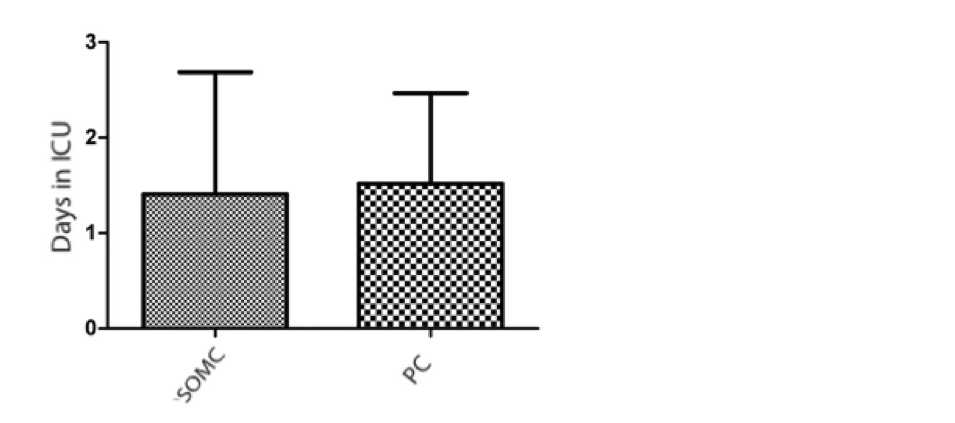
Figure 4. Length of intensive care unit (ICU) stay (in days) during the postoperative period in patients who underwent surgical treatment of cerebral aneurysms, excluding patients with surgical and/or clinical complications during hospitalization. The supraorbital minicraniotomy (SOMC) and pterional craniotomy (PC) techniques were used. The bar s represent the average ± standard deviation for SOMC (n = 27) and PC (n = 29) accesses in patients who underwent aneurysm surgery (unpaired Student’s t test; p =